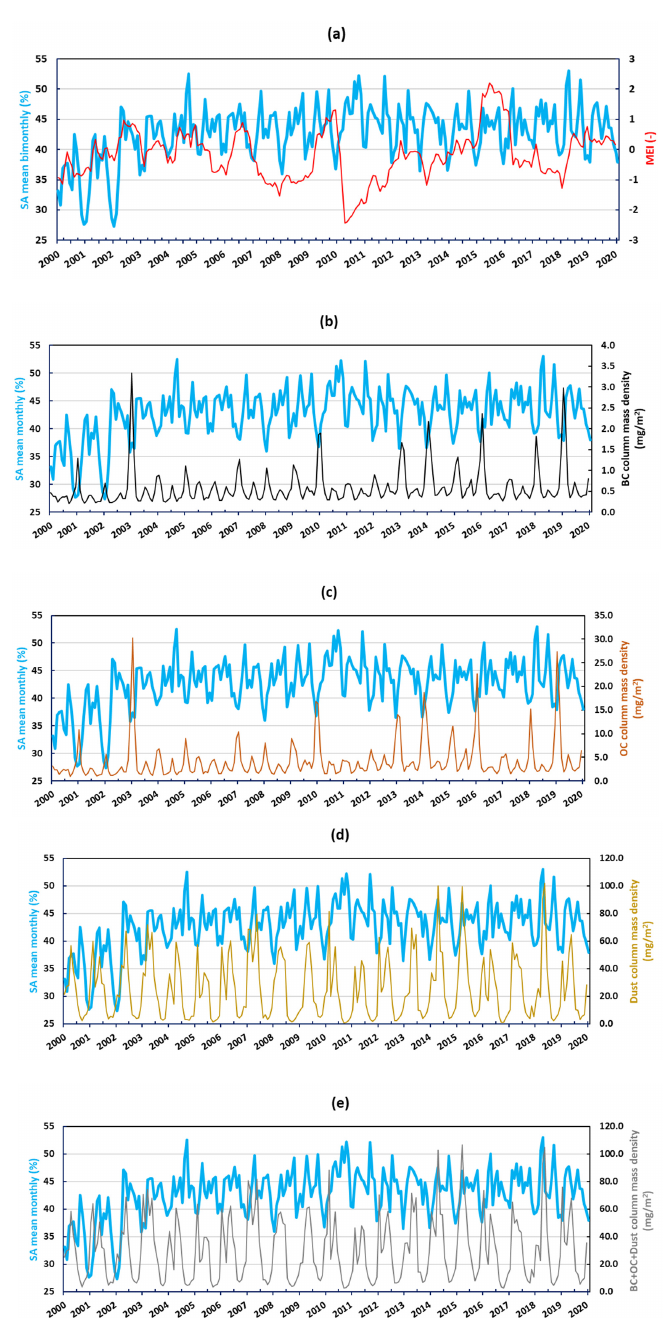
Figure 4. Monthly variation of SA mean with: ( a ) the bi-monthly multivariate ENSO index (MEI), ( b ) BC column mass density, ( c ) OC column mass density, ( d ) dust carbon column mass density, and ( e ) the combination of the three types of LAI particles analyzed (BC + OC + Dust), as column mass density from the MERRA-2 model [92]. (For interpretation of the references to color in this figure legend, the reader is referred to the web version of this article.)